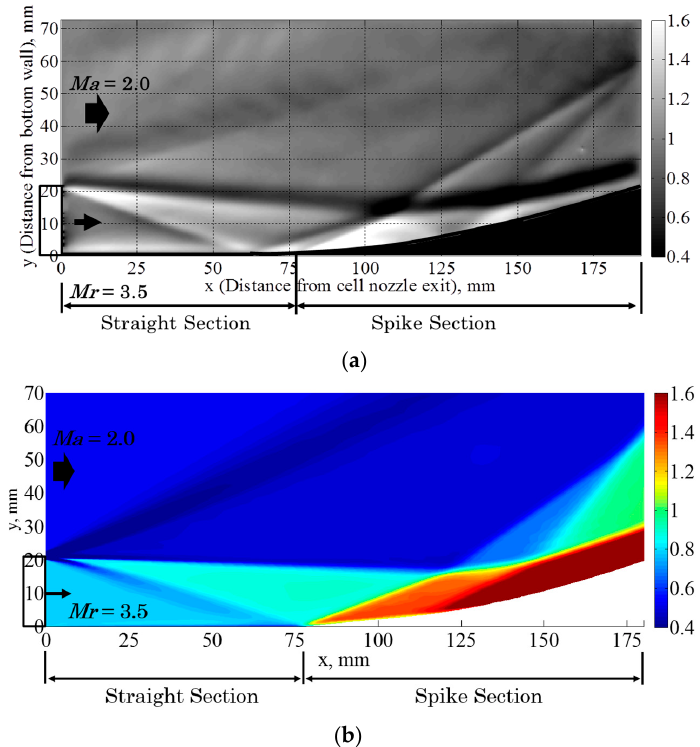
Figure 9. Comparison of qualitative flowfield feature between experiment and CFD for nozzle pressure ratio (NPR) = 49.5 and Mach 2.0 flight condition. Flow direction is from left to right. The color bar represents the normalized density based on the density value in the freestream region. ( a ) Density distribution obtained by the experiment using the background-oriented schlieren, adopted from Reference [30]; ( b ) Density distribution obtained by the CFD calculated for the aftbody nozzle flowfield corresponding to the experimental model.